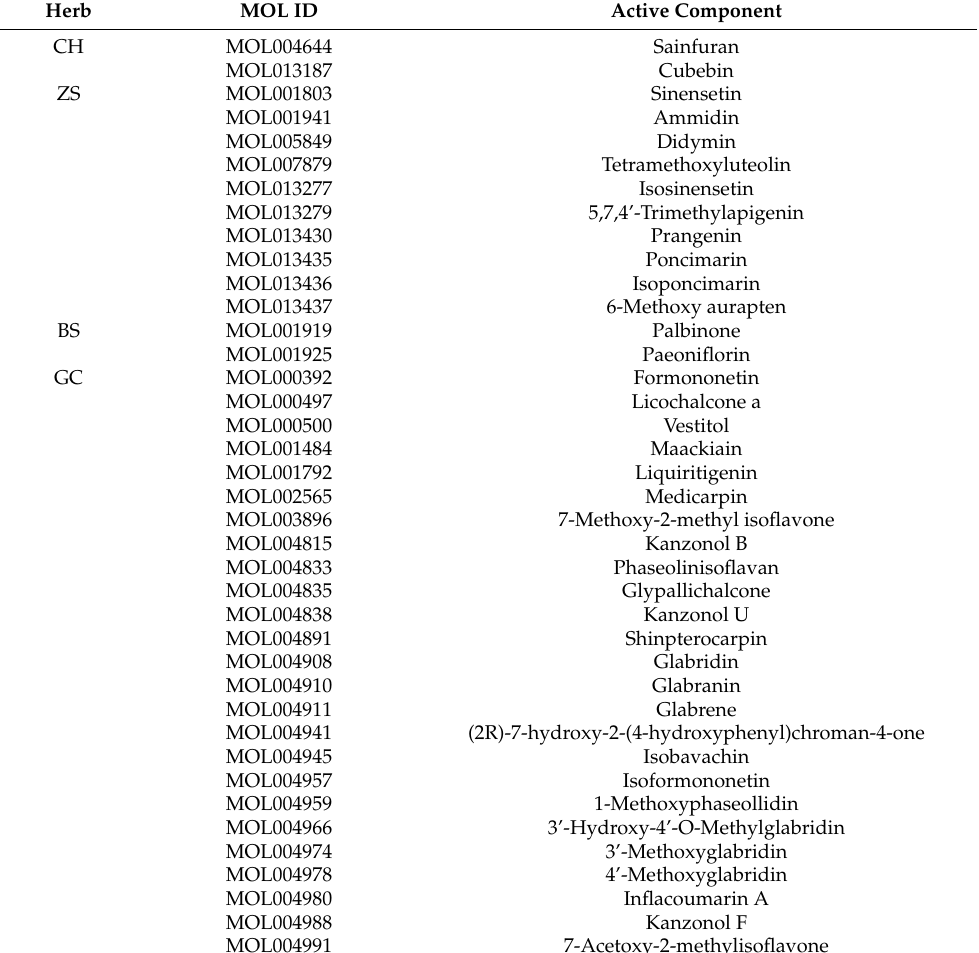
Table 1. Active components crossing the BBB of all 4 herbs of